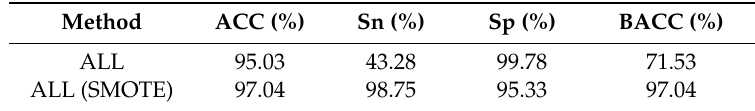
Table 7. The impact of synthetic minority oversampling technique (SMOTE) on the prediction results of the training